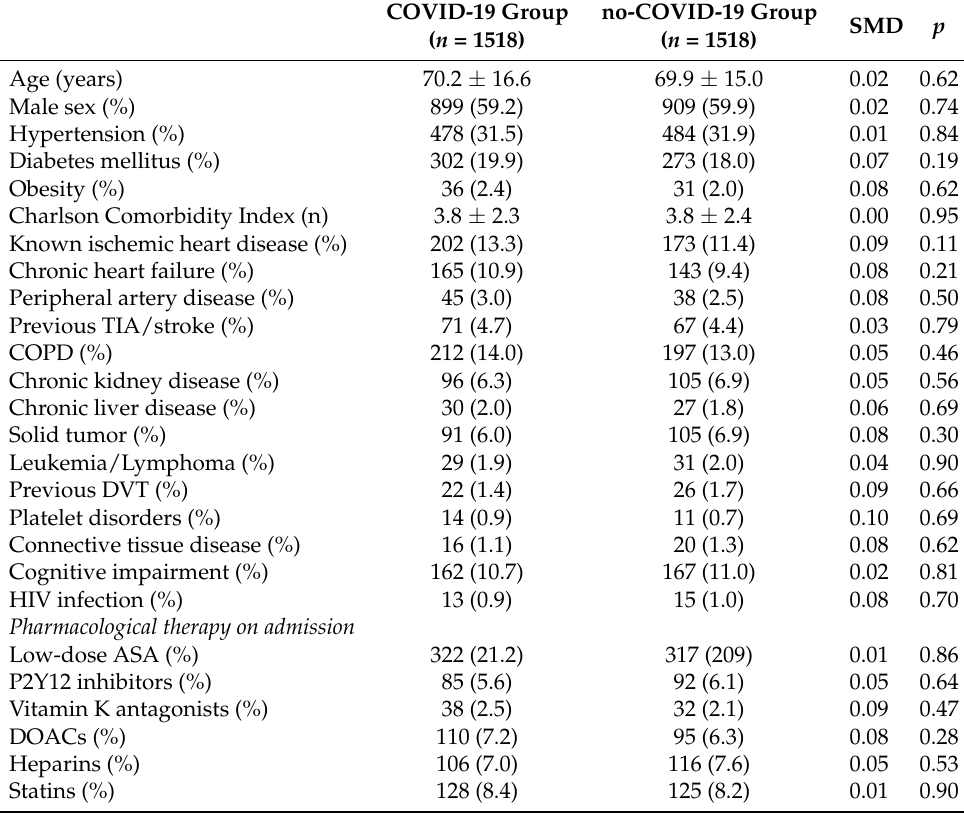
Table 3. Main clinical characteristics of propensity score-matched subgroups of patients.